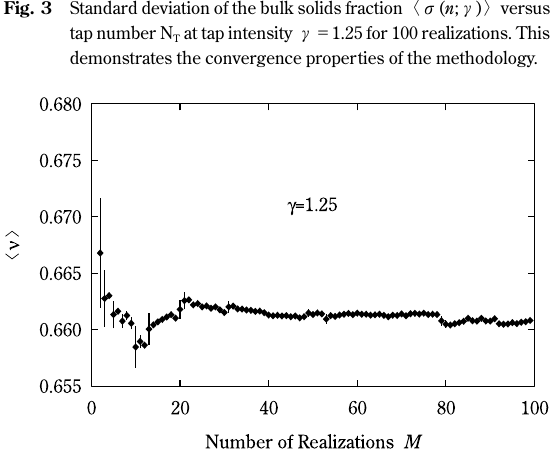
Fig. 4 Dependence of the ensembled-averaged bulk solids fraction on the number of realizations M at tap intensity γ＝ 1.25 to exhibit the sensitivity of the system to the ensemble size. The vertical lines through the points are error bars.